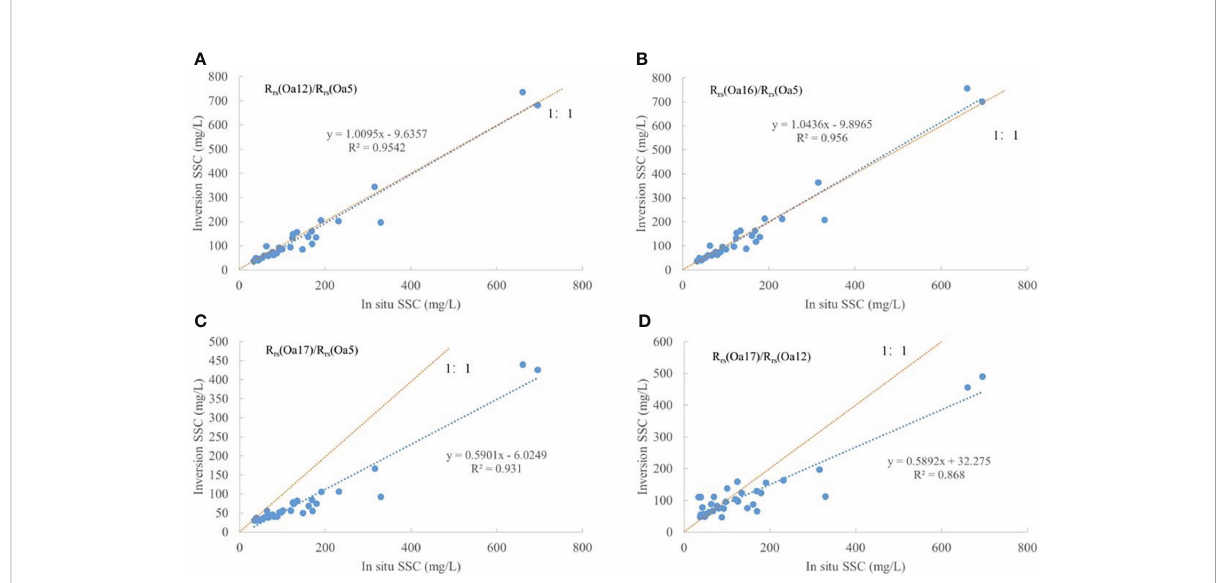
FIGURE 4 Scatter validation of estimated SSC based on OLCI data with in situ concentration. (A) R rs (Oa12)/R rs (Oa5); (B) R rs (Oa16)/R rs (Oa5); (C) R rs (Oa17)/R rs (Oa5); (D) R rs (Oa17)/R rs (Oa12).